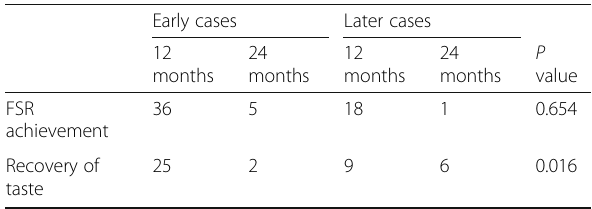
Table 2 Comparison of early and later treatment after lingual nerve injury at 12 months after